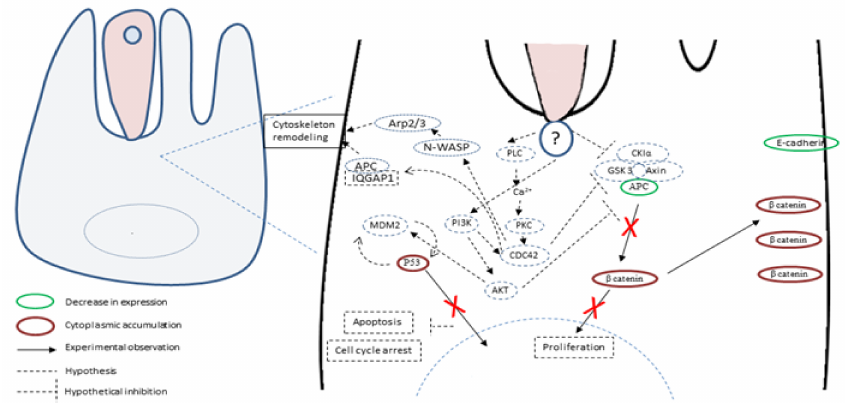
Figure 4. Hypothetical host-cell signaling pathways linking Cryptosporidium parvum infection and tumorigenesis. Di ff erent studies have shown that C. parvum induces cytoskeleton remodeling and actin reorganization through the implication of several intracellular signals, including phosphatidylinositol 3-kinase (PI3K) and Cdc42. In addition, in an experimental model, Adenomatous Polyposis Coli (APC) and E-cadherin labelings were decreased while β -catenin and the P53 tumor suppressor labelings were increased in the cytoplasm of C. parvum- infected epithelial cells. β -catenin was found localized in a juxtamembraneous position, suggesting a role of the non-canonical Wnt pathway in this transformation process. P53 was not translocated into the nucleus, and its labeling increased in the cytoplasm where P53 could regulate key metabolic pathways associated to apoptosis and cell cycle